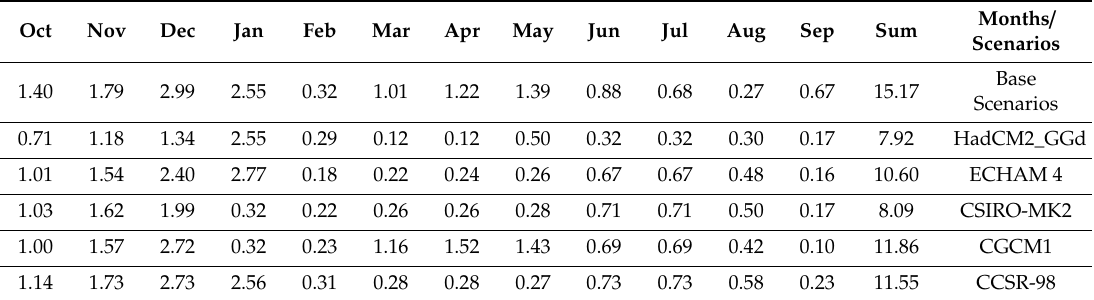
Table 4. Average water volume in million cubic meters for the base scenario and for the total executed climate change scenarios entering into the reservoir per